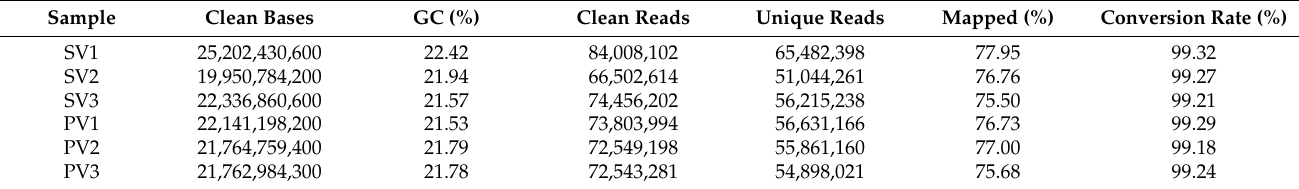
Table 1. Whole-genome bisulfite sequencing data in two sets of pecan grafts with different growth performances. SV: grafts with strong growth vigor on tall rootstocks; PV: grafts with poor growth vigor on short